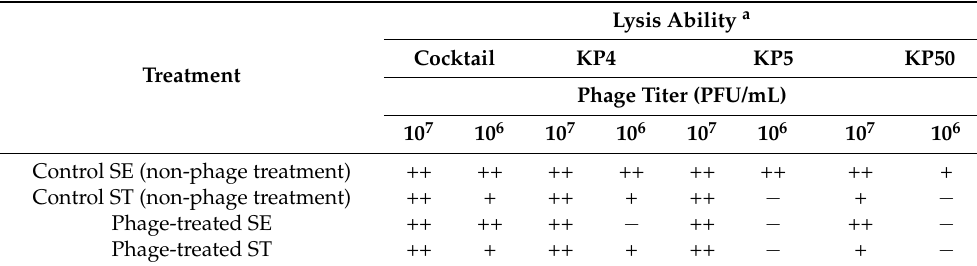
Table 7. Lysis ability of a phage cocktail and individual phages included in a phage cocktail preparation on S. Enteritidis (SE) and S. Typhimurium (ST) after being treated with a phage cocktail. Lysis Ability a Cocktail KP4 KP5 KP50 Treatment Phage Titer (PFU/mL) 10 7 10 6 10 7 10 6 10 7 10 6 10 7 10 6 Control SE (non-phage treatment) ++ ++ ++ ++ ++ ++ ++ + Control ST (non-phage treatment) ++ + ++ + ++ − + − Phage-treated SE ++ ++ ++ − ++ − ++ − Phage-treated ST ++ + ++ + ++ − +